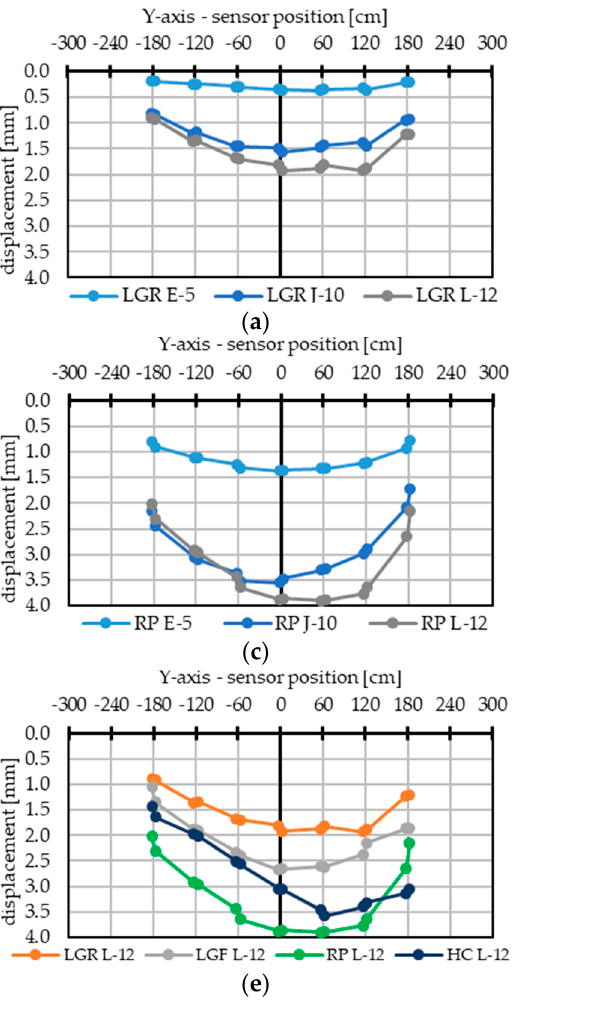
Figure 15. Displacements in the Y-axis for the sequences E-5, J-10, and L-12: ( a ) LGR; ( b ) LGF; ( c ) RP; ( d ) HC; ( e ) Comparison of panels and ( f ) performance of the panels in the Y-axis. Table 4. Maximum displacements of individual models under successive loading